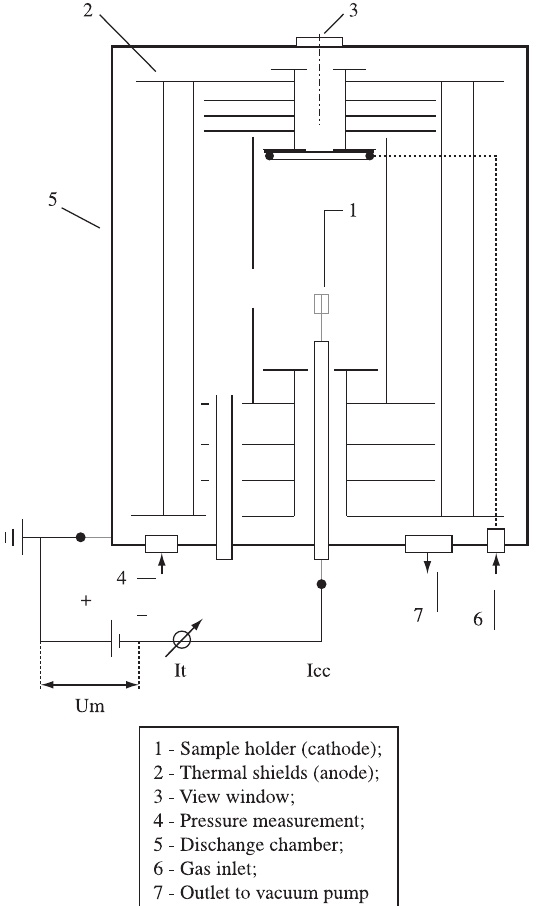
Figure 1. Plasma nitriding apparatus